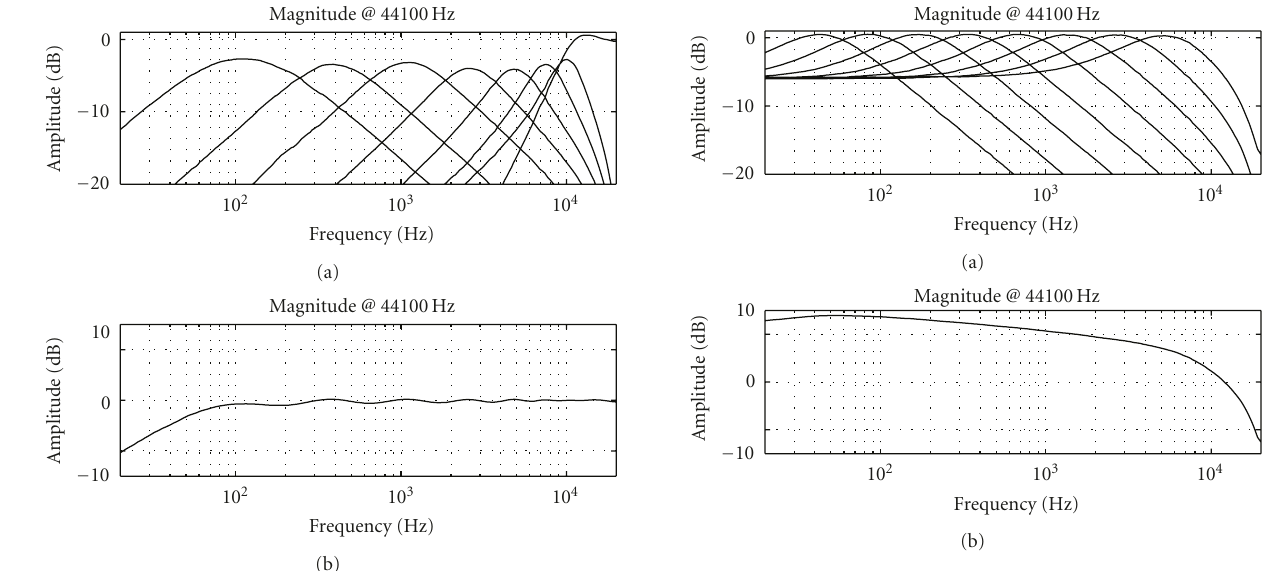
Figure 3: Lowpass filter decomposition filter bank (Type B filter bank for K = 8 ). (a) Filter bank comprised of a set of second order low-pass IIR Biquadratic filters with cuto ff frequencies as follows: 35Hz, 80Hz, 187.5 Hz, 375 Hz, 750 Hz, 1.5 kHz, 3kHz, and 6 kHz. (b) Combined response of the filter bank. All gains have been set to have a maximum peak value of